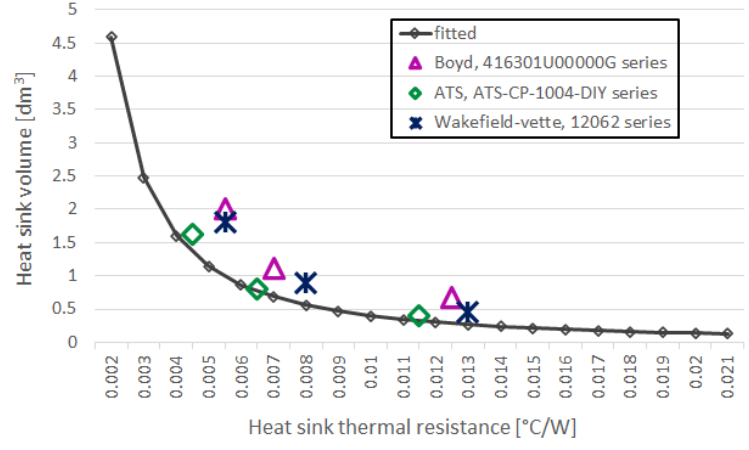
Figure 3. The volume of liquid cold plate heat sinks from different manufacturers.